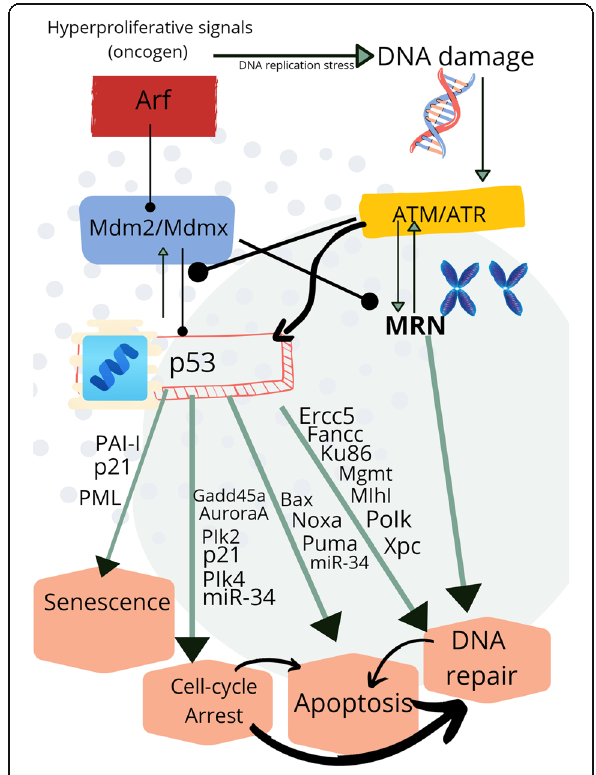
Fig. 2 Different pathways activated by P53 in response to DNA damage